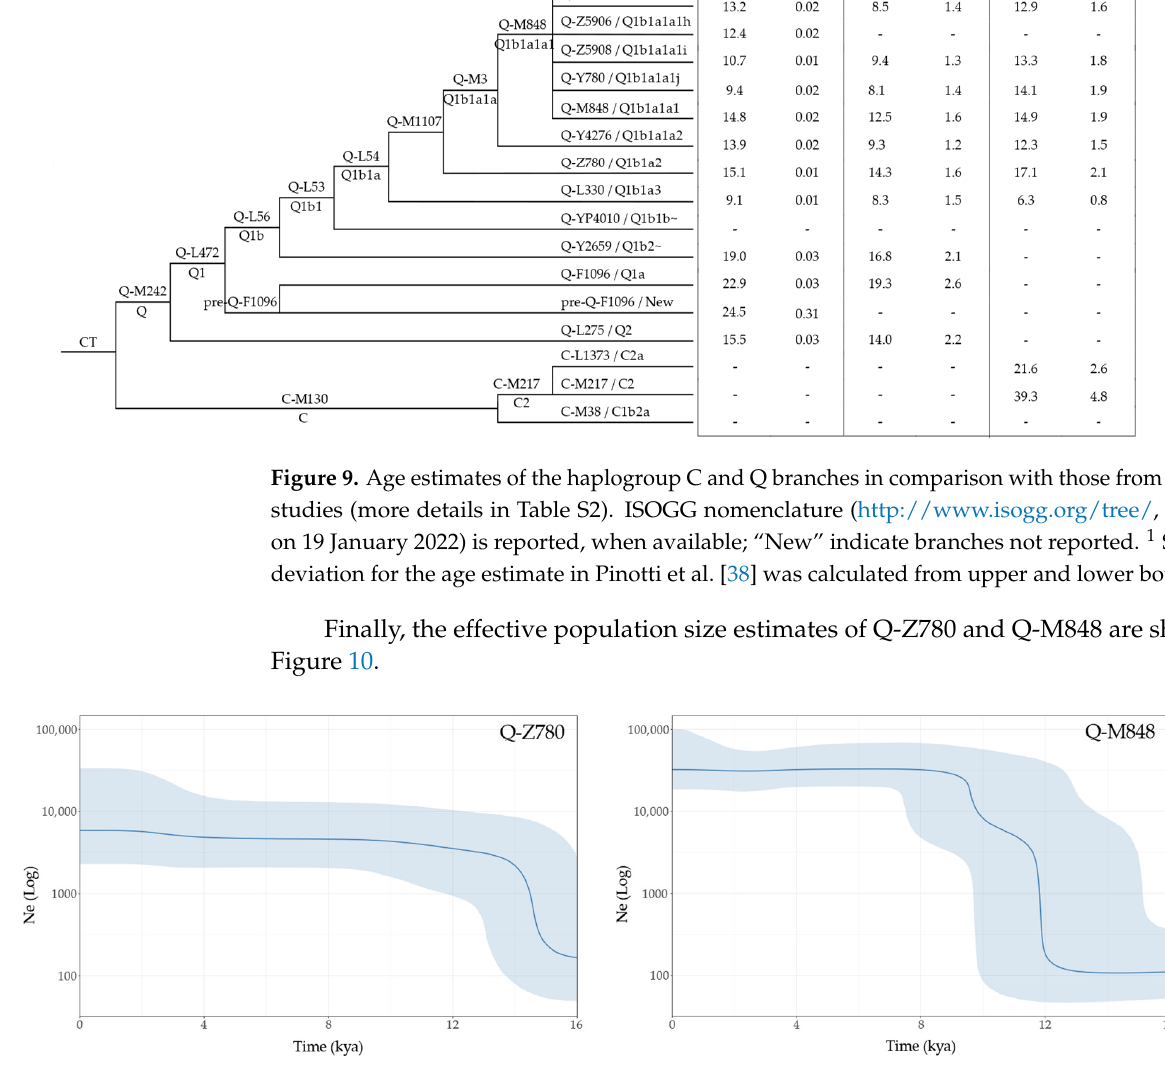
Figure 10. Bayesian skyline plots of Q-Z780 and Q-M848. Only Native American high coverage (HC) Y chromosomes were considered ( N = 13, N = 81, respectively). The radiocarbon dates of the following ancient individuals were used as priors for time estimates: Anzick-I [47], Ahur, Sumidouro5, A460, [11], CUN008 [14] for haplogroup Q-M848; I2261 and I0038 [14] for Q-Z780. The x-axis is in thousand years ago, and the y-axis shows changes in effective population size in logarithmic scale. The darker lines trace the median estimates, and the shadings show 95% highest posterior density intervals of the Ne. The time axis is limited to 16 kya, beyond which the curve remains flat.